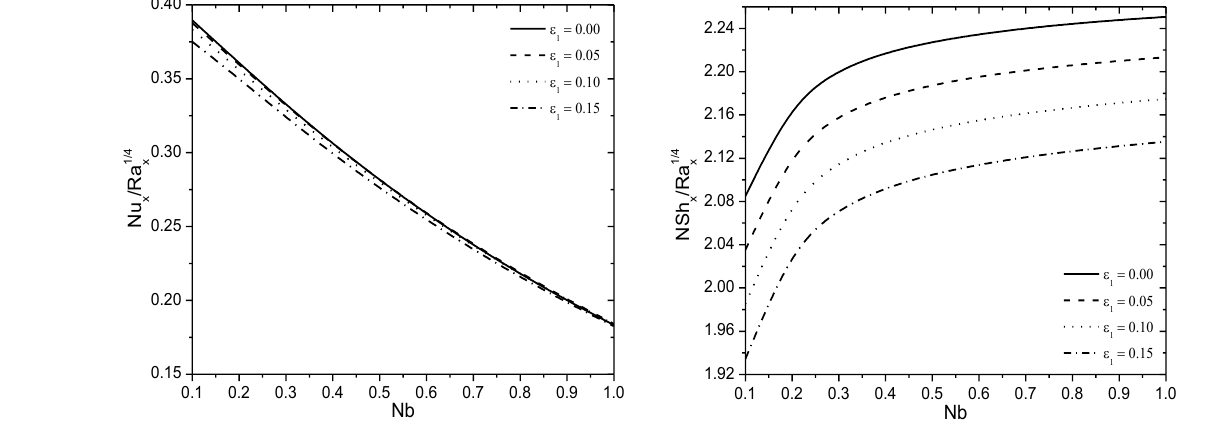
 on the Local Nusselt number Figure 18. Effet of Figure 17. Effet of 1